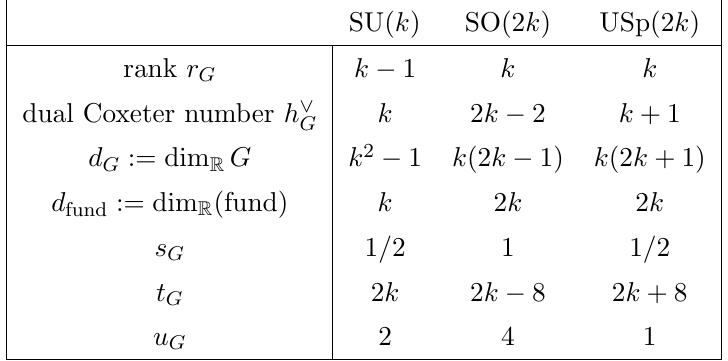
Table 3. The group theory constants appearing in (D.10) and (D.11). Notice that t constants are taken from [51, 90].